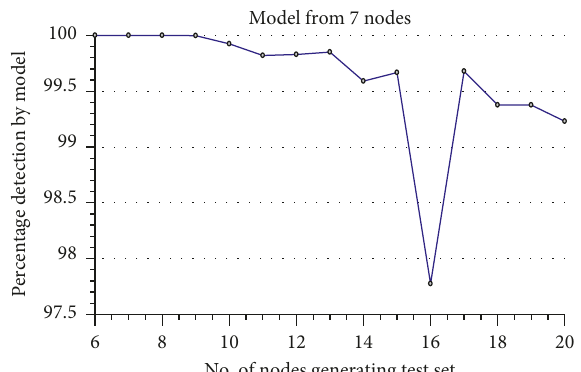
Figure 12: Simulation results of 12 nodes.